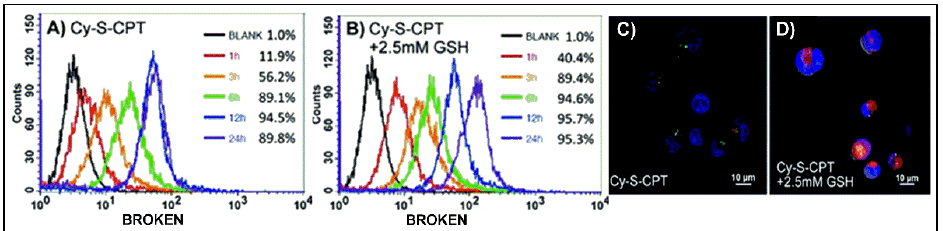
Figure 60. Cellular uptake and intracellular trafficking of prodrugs 64 (Cy-S-CPT) in BCap-37 cells: flow cytometry analysis of the cellular uptake and activation for 64 ( A , B ) with and without 2.5 mM GSH, and images of BCap-37 cells cultured with 64 with ( C ) or without ( D ) GSH for 2 h. Red signal indicates the fluorescence from cyanine dye ( λ EX = 530 nm, λ EM = 650 nm) representing the prodrug activation by GSH. Adapted with permission from [168]. Copyright (2016) The Royal Society of Chemistry.